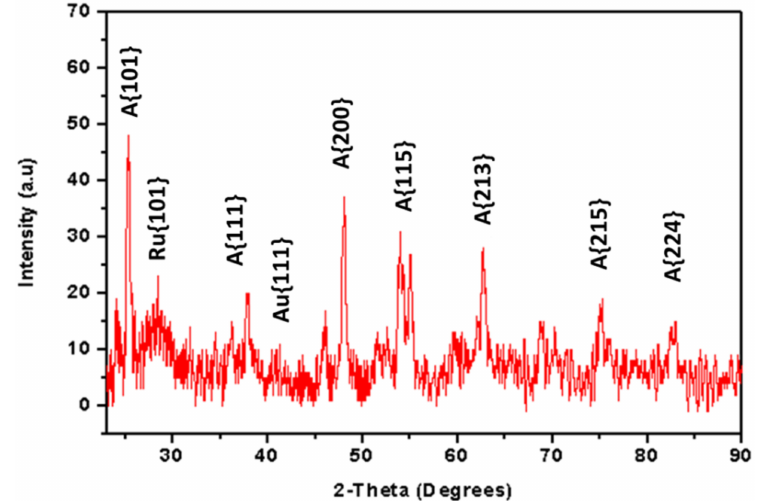
Figure 7. XRD pattern of Au/TiO 2 nanocomposite (0.7